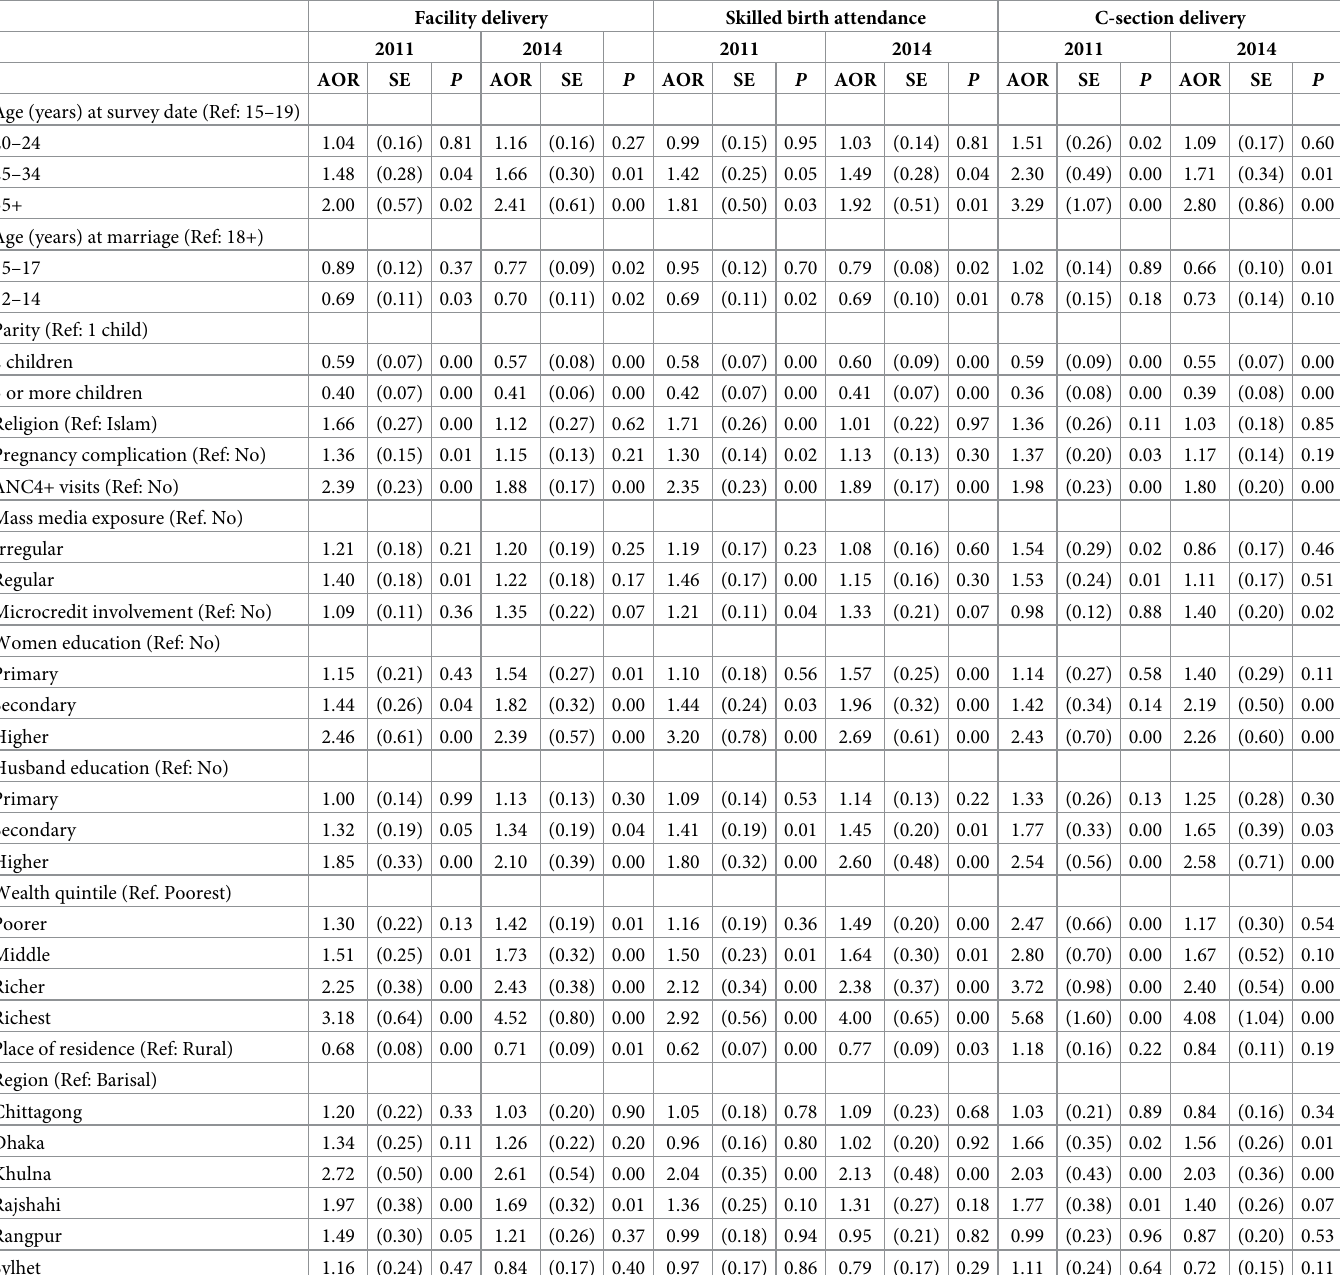
Table 2. Multivariate logistic regression results for the factors associated with the use of delivery care